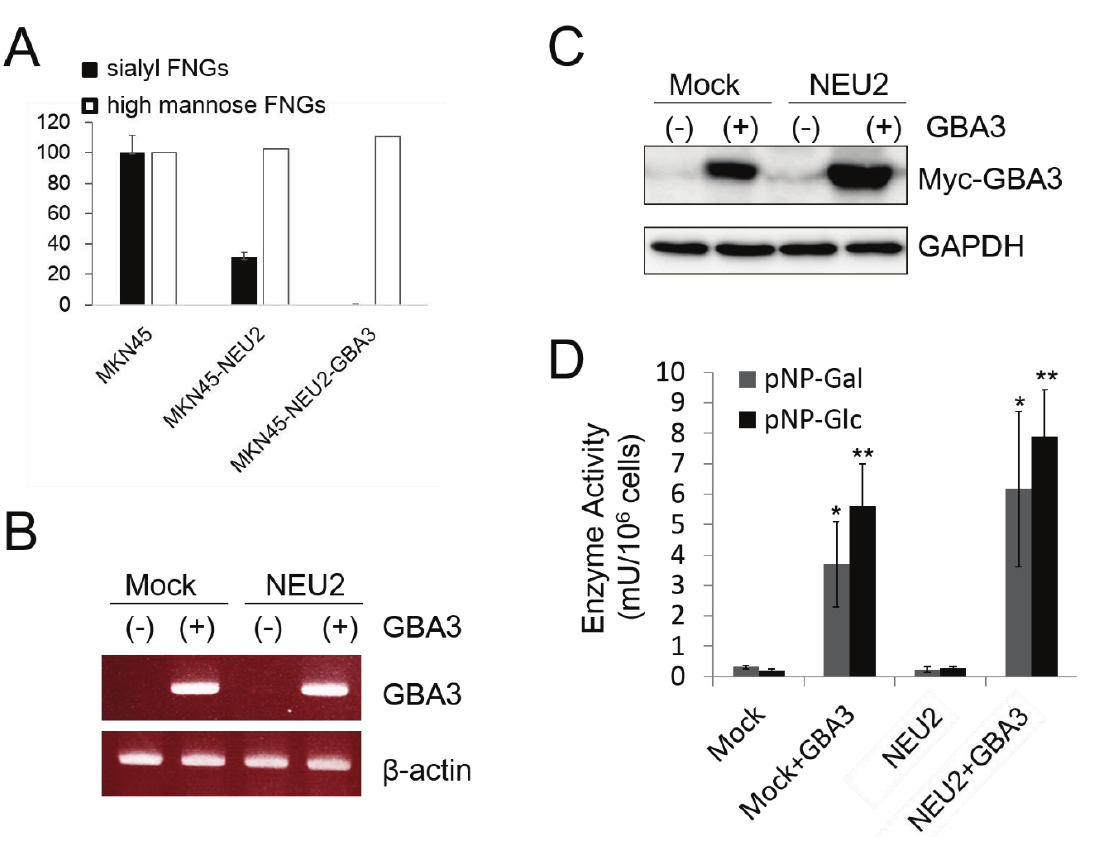
Figure 1. Expression of GBA3 in MKN45-Mock cells and MKN45-NEU2 cells. ( A ) Quantitation of sialyl FNG (Neu5Ac(cid:3)2-6Gal(cid:2)1-4GlcNAc(cid:2)1-2Man(cid:3)1-3Man(cid:2)1-4GlcNAc) (closed bar; n = 3) and high mannose-type FNG (Man 5-6 GlcNAc) (open bar; n = 1), in MKN45, MKN45-NEU2, and MKN45-NEU2/GBA3 cells. Amount of the sialylglycan or the